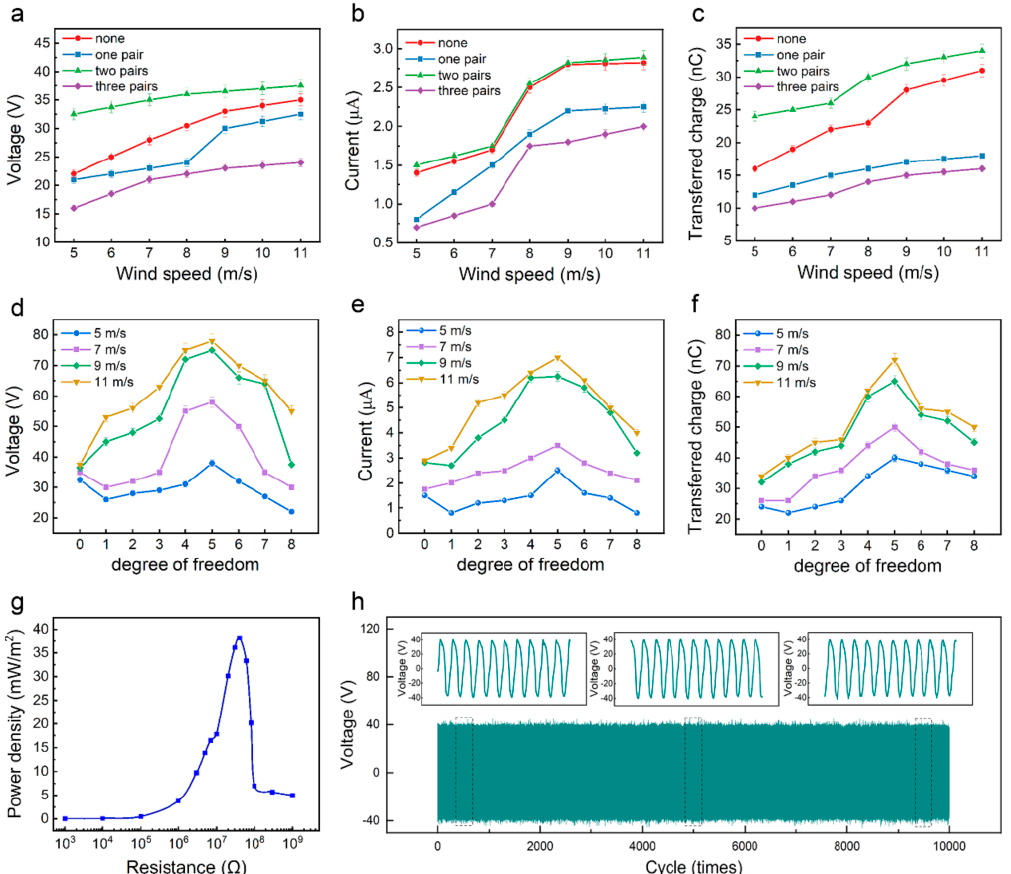
Figure 3. Electrical output performance of the HF-TENG under different pair numbers of supporting sponge strips and degrees of freedom. ( a ) V OC , ( b ) Isc , and ( c ) Qsc of the HF-TENG under various wind speeds when the pair number of supporting sponge strips is 0, 1, 2, 3. ( d ) V OC , ( e ) Isc , and ( f ) Qsc of the HF-TENG with different degrees of freedom. ( g ) Dependence of the peak power density on the loading resistances of the HF-TENG. ( h ) Electrical output stability of the HF-TENG. Another way to improve the contact degree of triboelectric surfaces is to divide the PTFE membrane into a multi-degree of freedom with equal area in the length direction. Each piece can move freely and flexibly, and there is no space limitation between each other. To explore the optimal degree of freedom of the PTFE membrane, nine different degrees of freedom of P1200-ground HF-TENGs with two pairs of supporting sponge strips are fabricated, and their output performance is compared. Figure 3d shows the re- lationship between the V OC of the nine different HF-TENGs mentioned above and the number of degrees of freedom. With the increase in degree of freedom, the V OC values of HF-TENGs show a trend of first rising and then falling, and all reach the maximum value